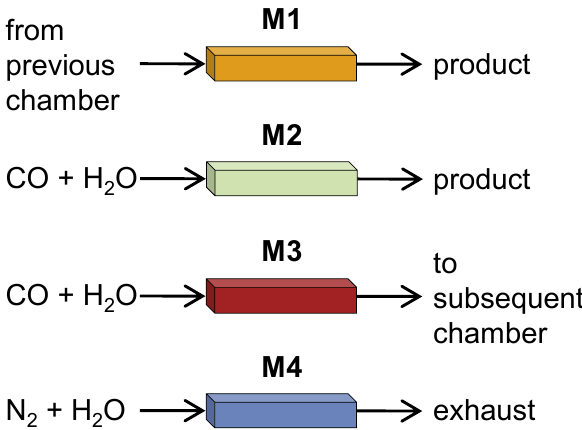
Figure 8. Process operation modes. M1: feed from previous chamber, outlet product; M2: reaction feed, outlet product; M3: reaction feed, outlet to subsequent chamber; M4: regeneration feed, outlet exhaust.